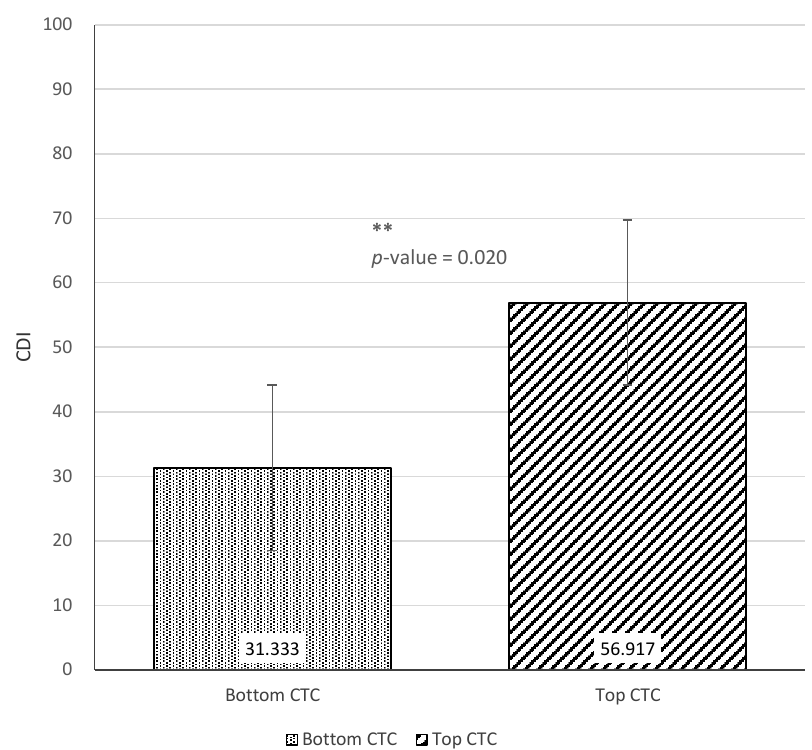
Figure 7. Difference in Communicative Development Inventories scores between top and bottom terciles of Conversational Turn Count. ** p < 0.05. Table 6. Multivariate correlations between AWC, CTC, CVC and CDI.